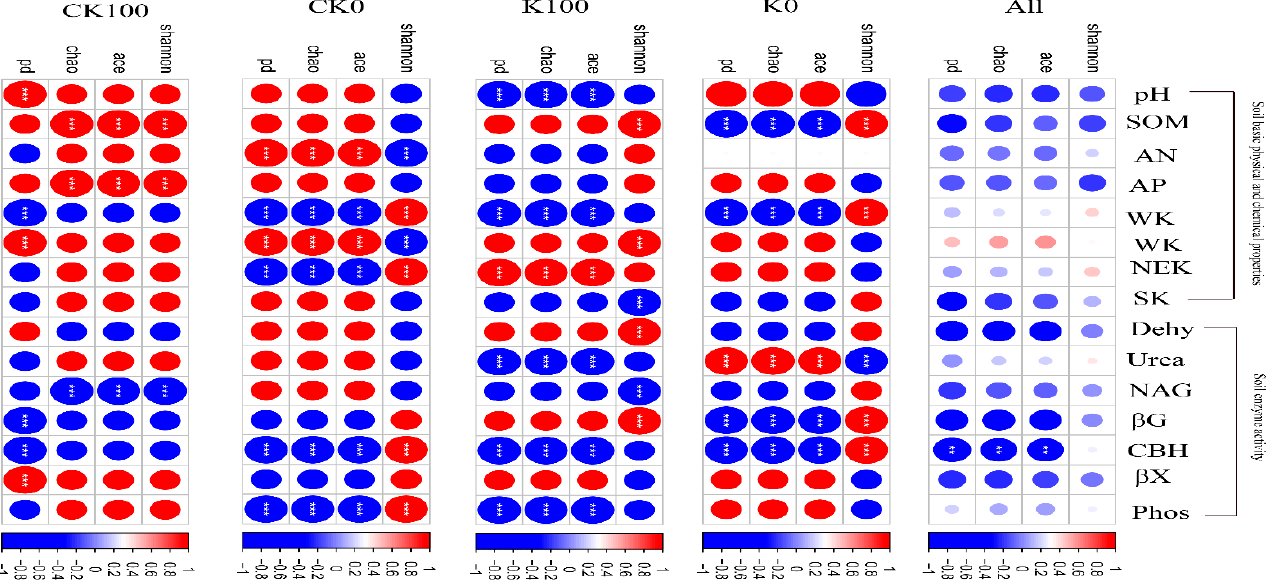
Figure 2. Panel shows heatmaps of Spearman’s rank correlation coefficients of fungal alpha-diversity metrics with soil physicochemical properties for the entire set of soil samples (All) and subsets of different soil depths (K0, K100, CK0, and CK100). *** Correlation is significant at the 0.001 level. ** Correlation is significant at the 0.01 level. Blue indicates a negative correlation, and red indicates a positive correlation.